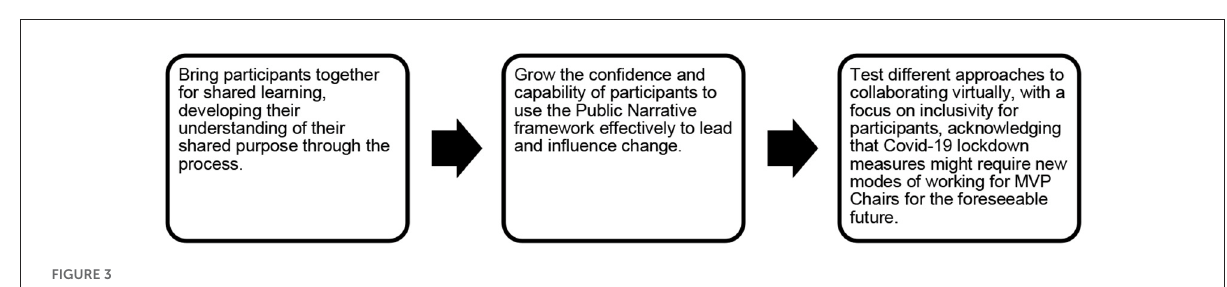
FIGURE3 Public Narrative pilot training